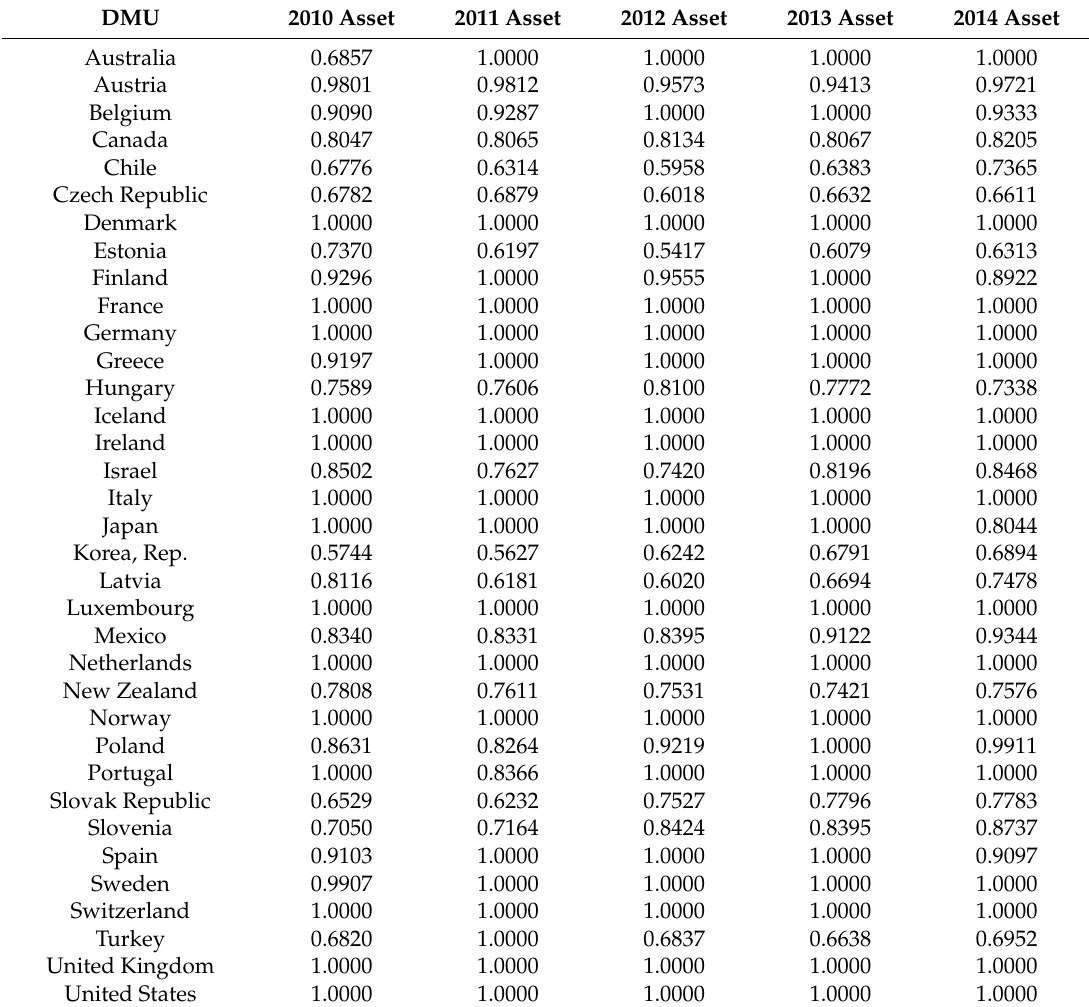
Table 4. Fixed asset efficiency from